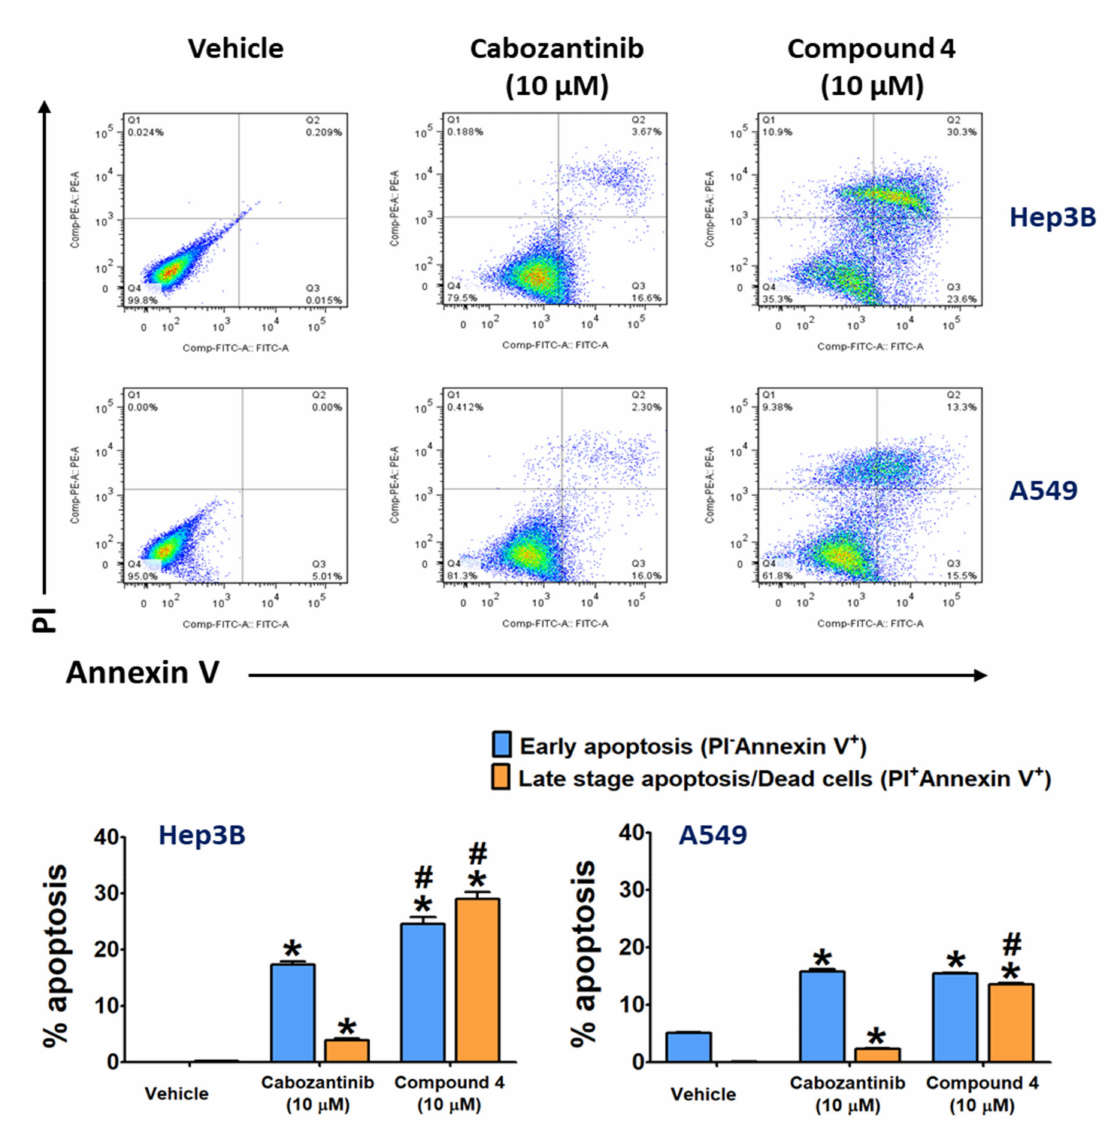
Figure 5. Effects of cabozantinib and compound 4 on apoptosis induction. Hep3B and A549 cells were treated with cabozantinib and compound 4 at 10 µ M for 48 h. The apoptosis of the cells stained with propium iodide and annexin V-FITC was analyzed by FACS. Lower left quadrant, viable cells (annexin V-FITC and PI negative); lower right quadrant, early apoptotic cells (annexin V-FITC positive and PI negative); upper right quadrant, late-stage apoptotic cells that have already died (annexin V-FITC and PI positive). The bar chart represents the percentage of early apoptosis and late-stage apoptotic/necrotic cells ( n = 3). * p < 0.05, compared to vehicle-treated control. # p < 0.05, compared to the cabozantinib-treated